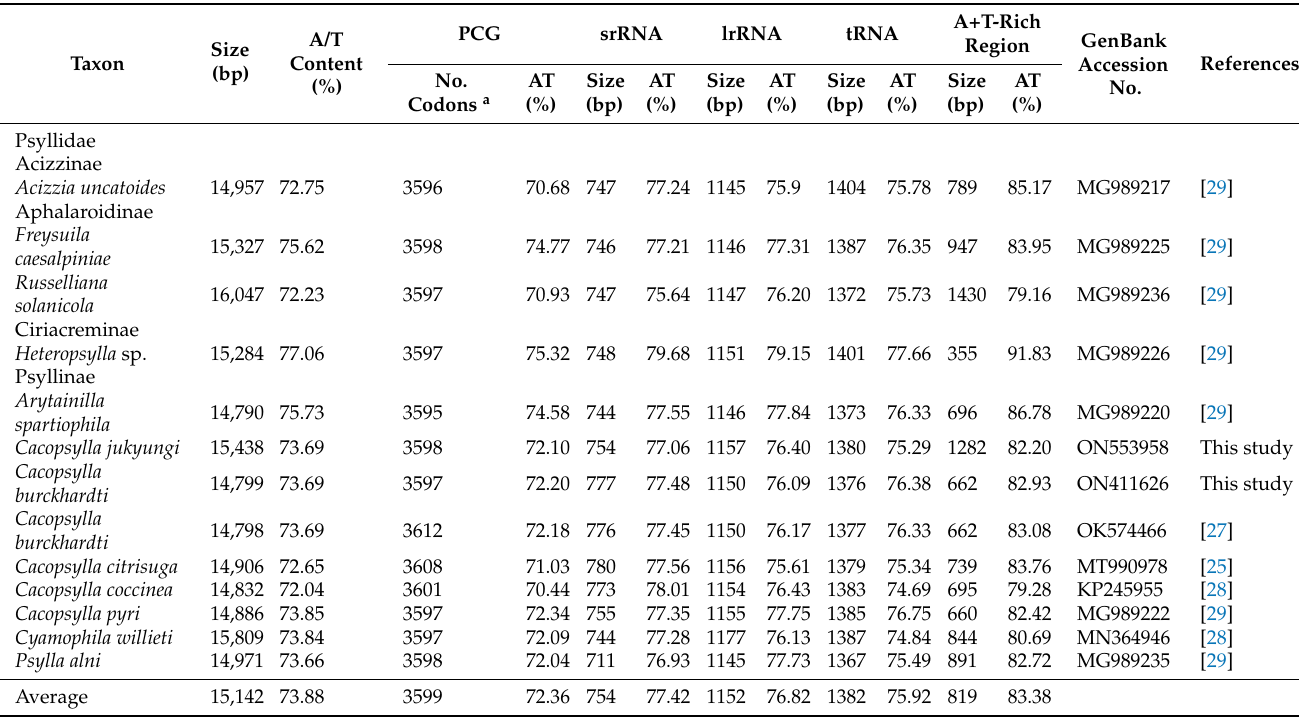
Table 2. Characteristics of 13 mitochondrial genomes of Psyllidae species.